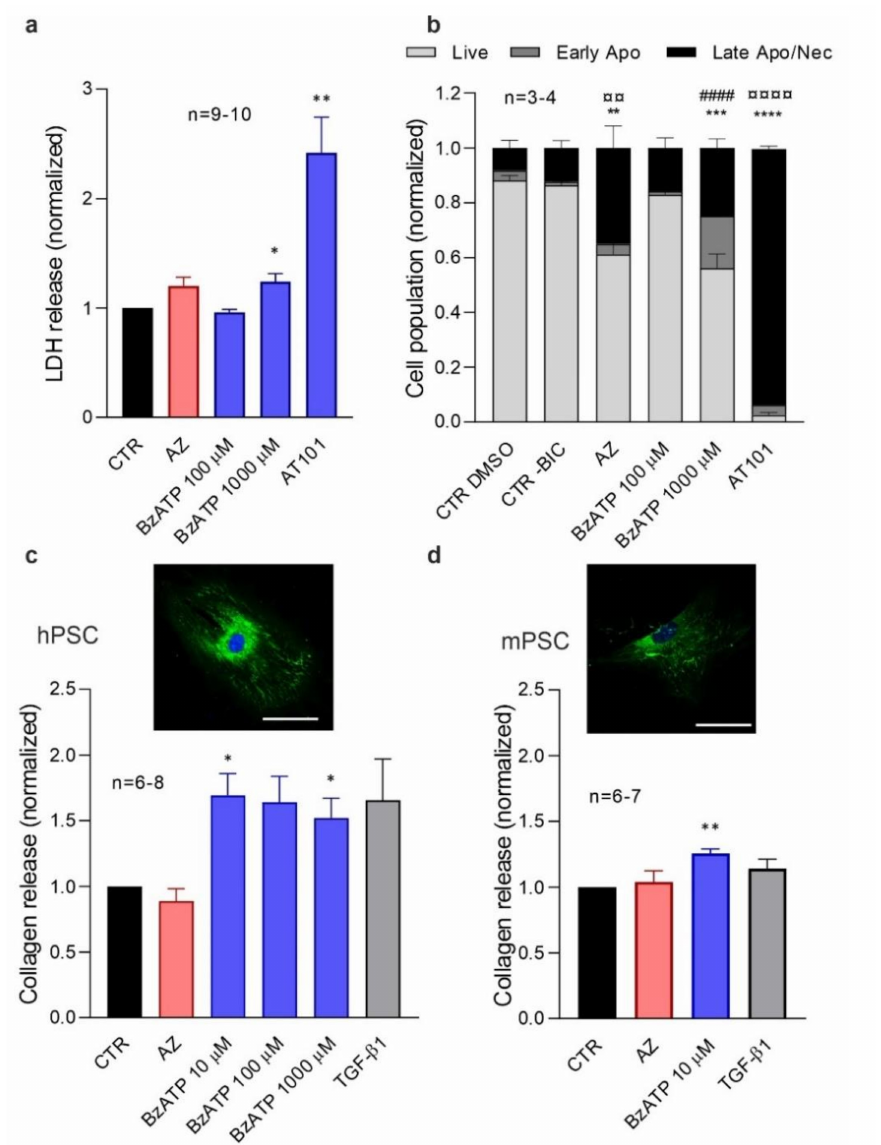
Figure 3. Effect of P2X7R on cell survival and collagen release. ( a , b ) Effects of 10 µ M AZ10606120 (AZ) and different concentrations of BzATP on ( a ) LDH release ( b ) and live/dead cell population (flow cytometry analysis) on hPSCs. ( c , d ) Collagen release and representative images of collagen staining are shown for hPSCs and mPSCs (P2X7R wt ). Scale bar is 50 µ m. Data are normalized to the control values (CTR). AT101 10 µ M and TGF- β 1 5 ng/ µ l were used as positive controls. Statistical analysis was as above and significance is indicated by ( a ) * p < 0.05, ** p < 0.01; ( c ) * p < 0.05; ( d ) ** p < 0.01. We analyzed the flow cytometry data with one-way ANOVA followed by Bonferroni correction and compared to the control and significant difference for live (*), early apoptosis (#), late apoptosis/necrosis (¤) is indicated by the following: ** ¤¤ p < 0.01; *** p < 0.001; **** #### ¤¤¤¤ p <